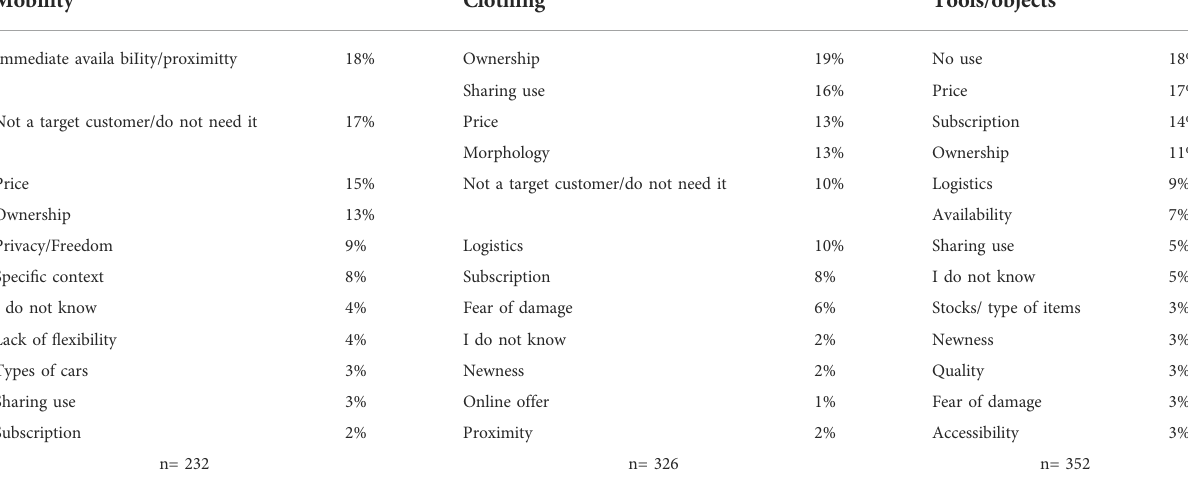
TABLE 3 Barriers expressed by survey participants, ordered by their relative weights in the responses.